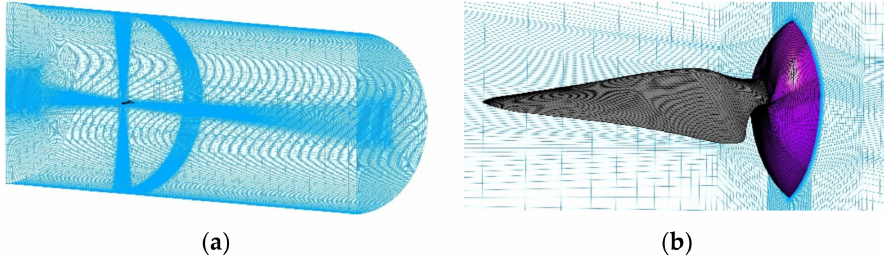
Figure 6. Computational mesh of the test propeller: ( a ) Computational domain; ( b ) Near-wall grids